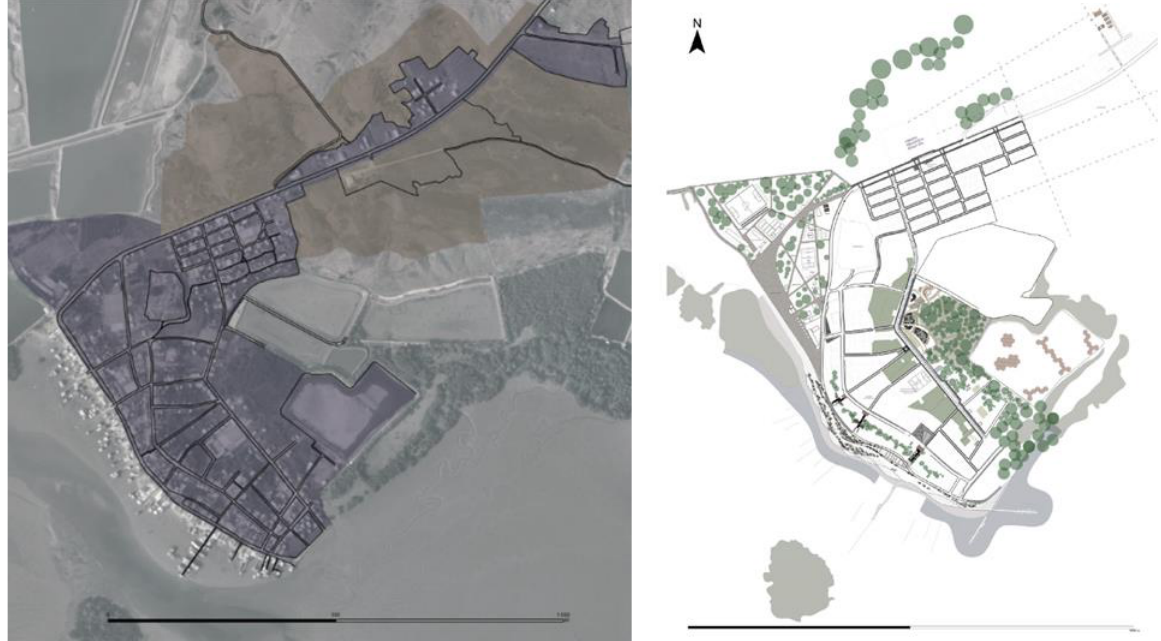
Figure 6. Proposed Urban Development Plan ( left ) Proposed waterfront park ( right ) (Source MIDUVI- Ministry of Urban Development and